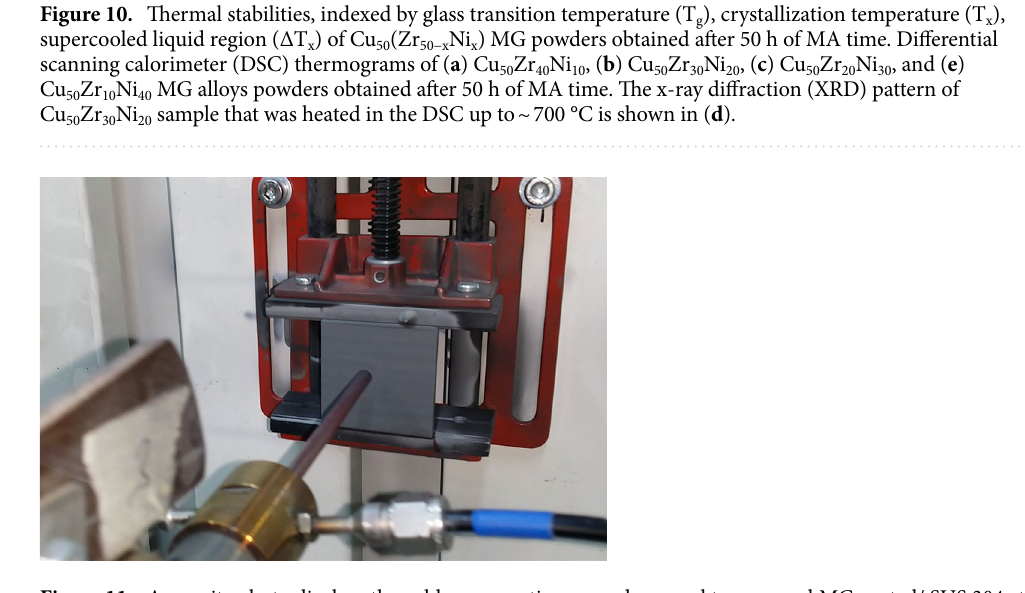
Figure 11. An onsite photo displays the cold spray coating procedure used to prepared MG coated/ SUS 304 at 550 °C for five continuous